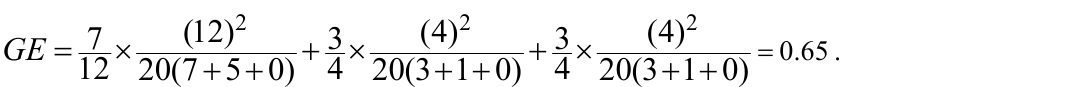
Efficiency of the system and sub-system, Sparsity index, Efficacy index, using CGE for problem 1 problem Efficiency of Sparsity Index Efficacy Index Efficiency of individual cells block -diagonal system (CGE)